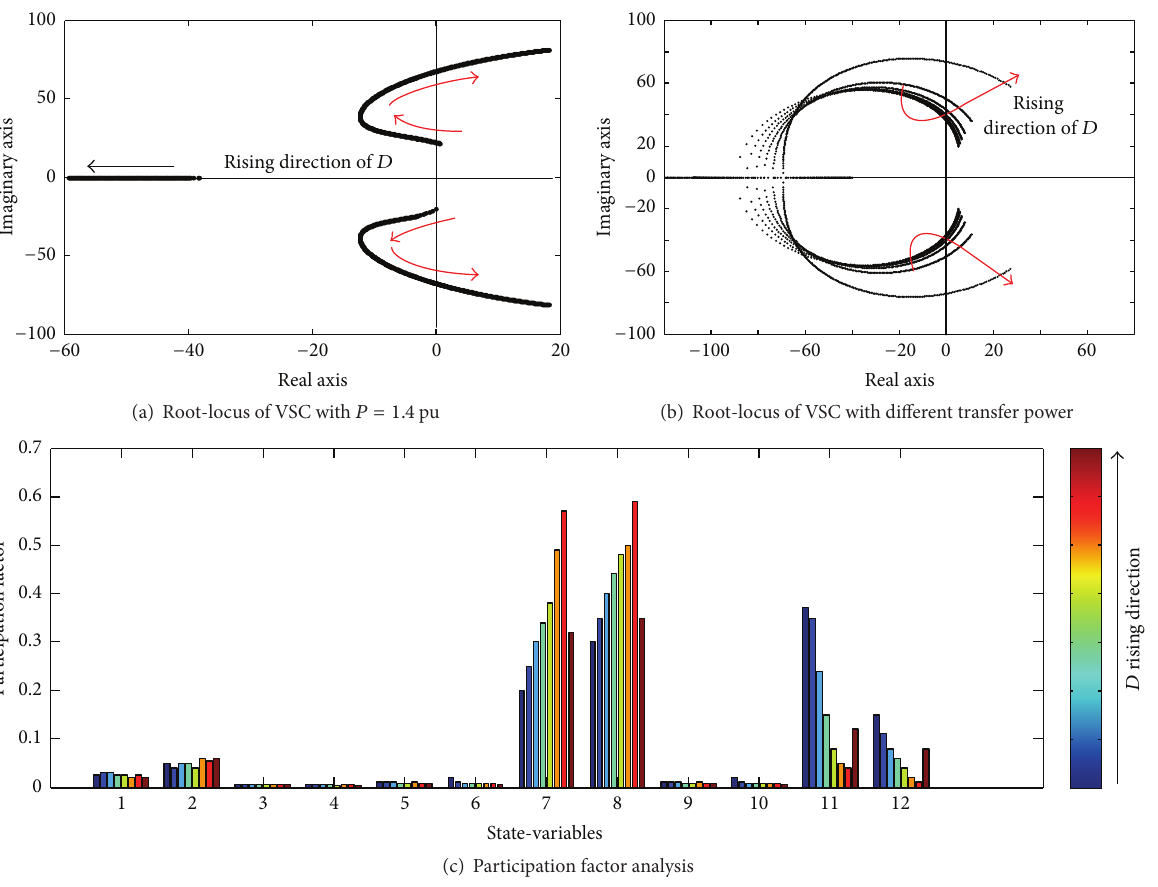
Figure 7: Root-locus and participation factor of system with advanced PLL